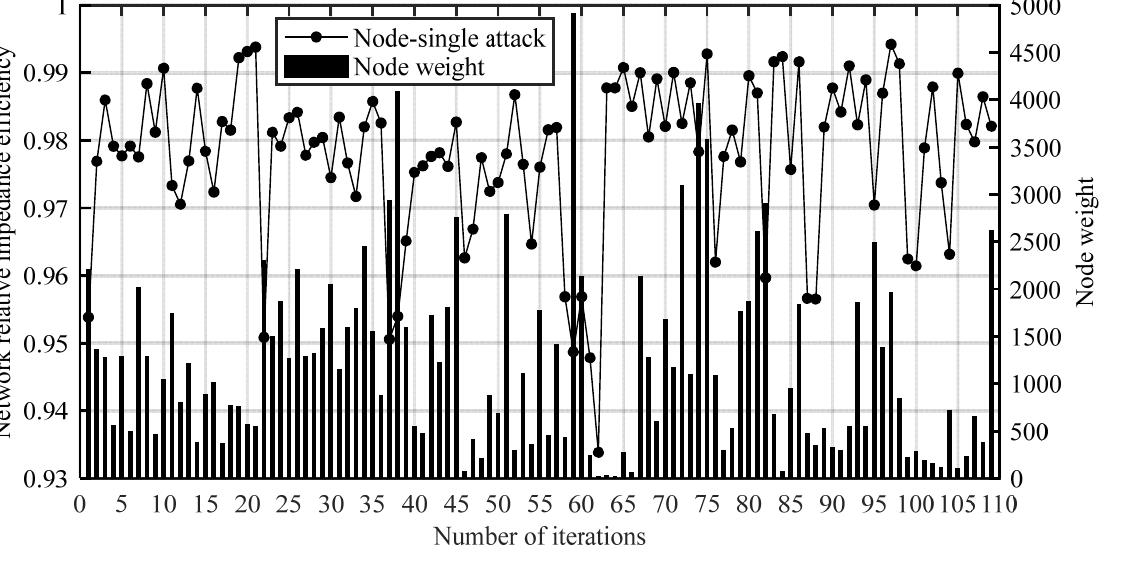
Figure 9. Comparison of node weight and node ‐ single attack results.